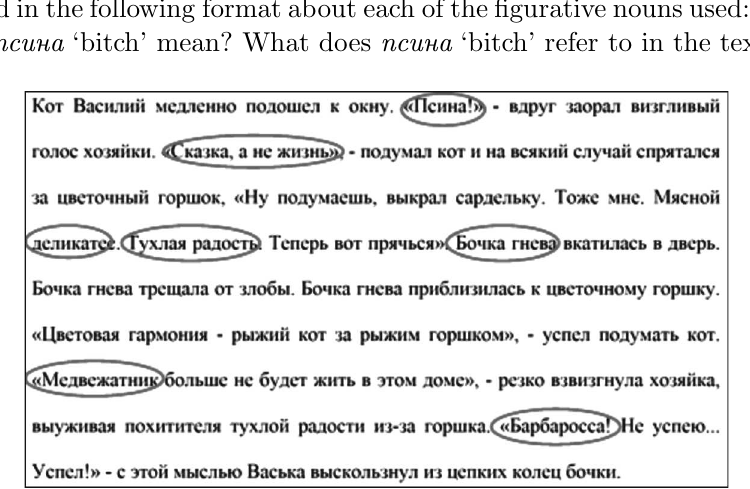
Figure 1. Stimulus text with figurative nouns and noun phrases